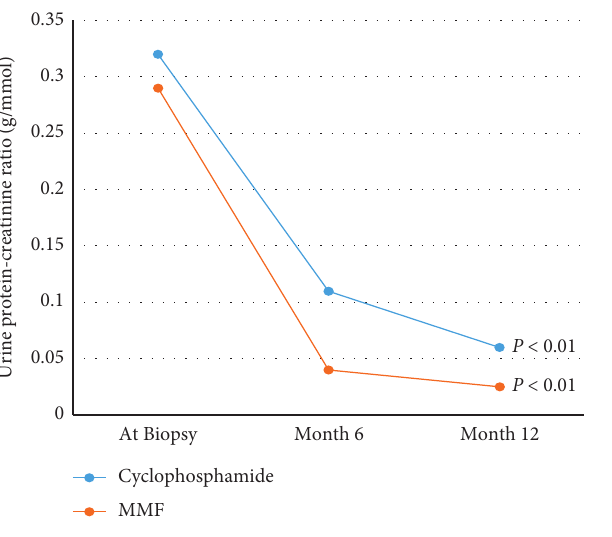
Figure 1: Trend in proteinuria in both groups over the study period (MMF: mycophenolate